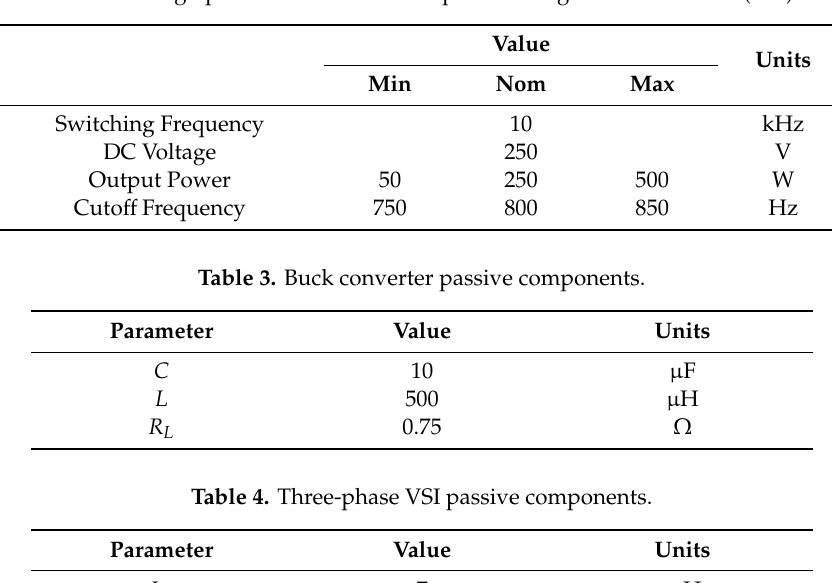
Table 2. Design parameters of the three-phase Voltage Source Inverter (VSI).